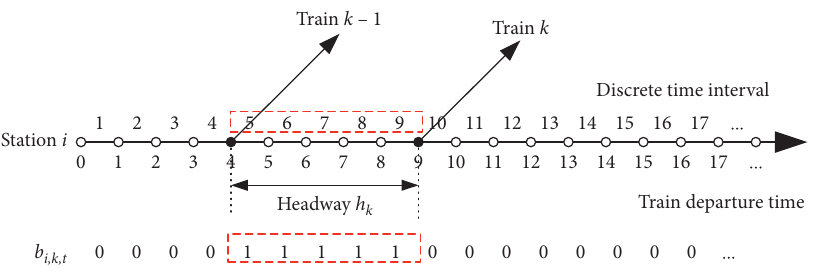
Figure 2: Illustration of train